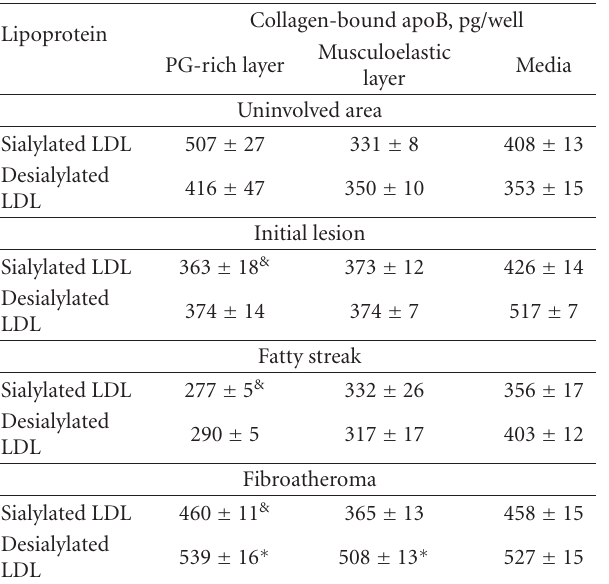
Table 4: Binding of sialylated and desialylated HDL to collagen isolated from two layers of the intima and the media of uninvolved and atherosclerotic areas of human